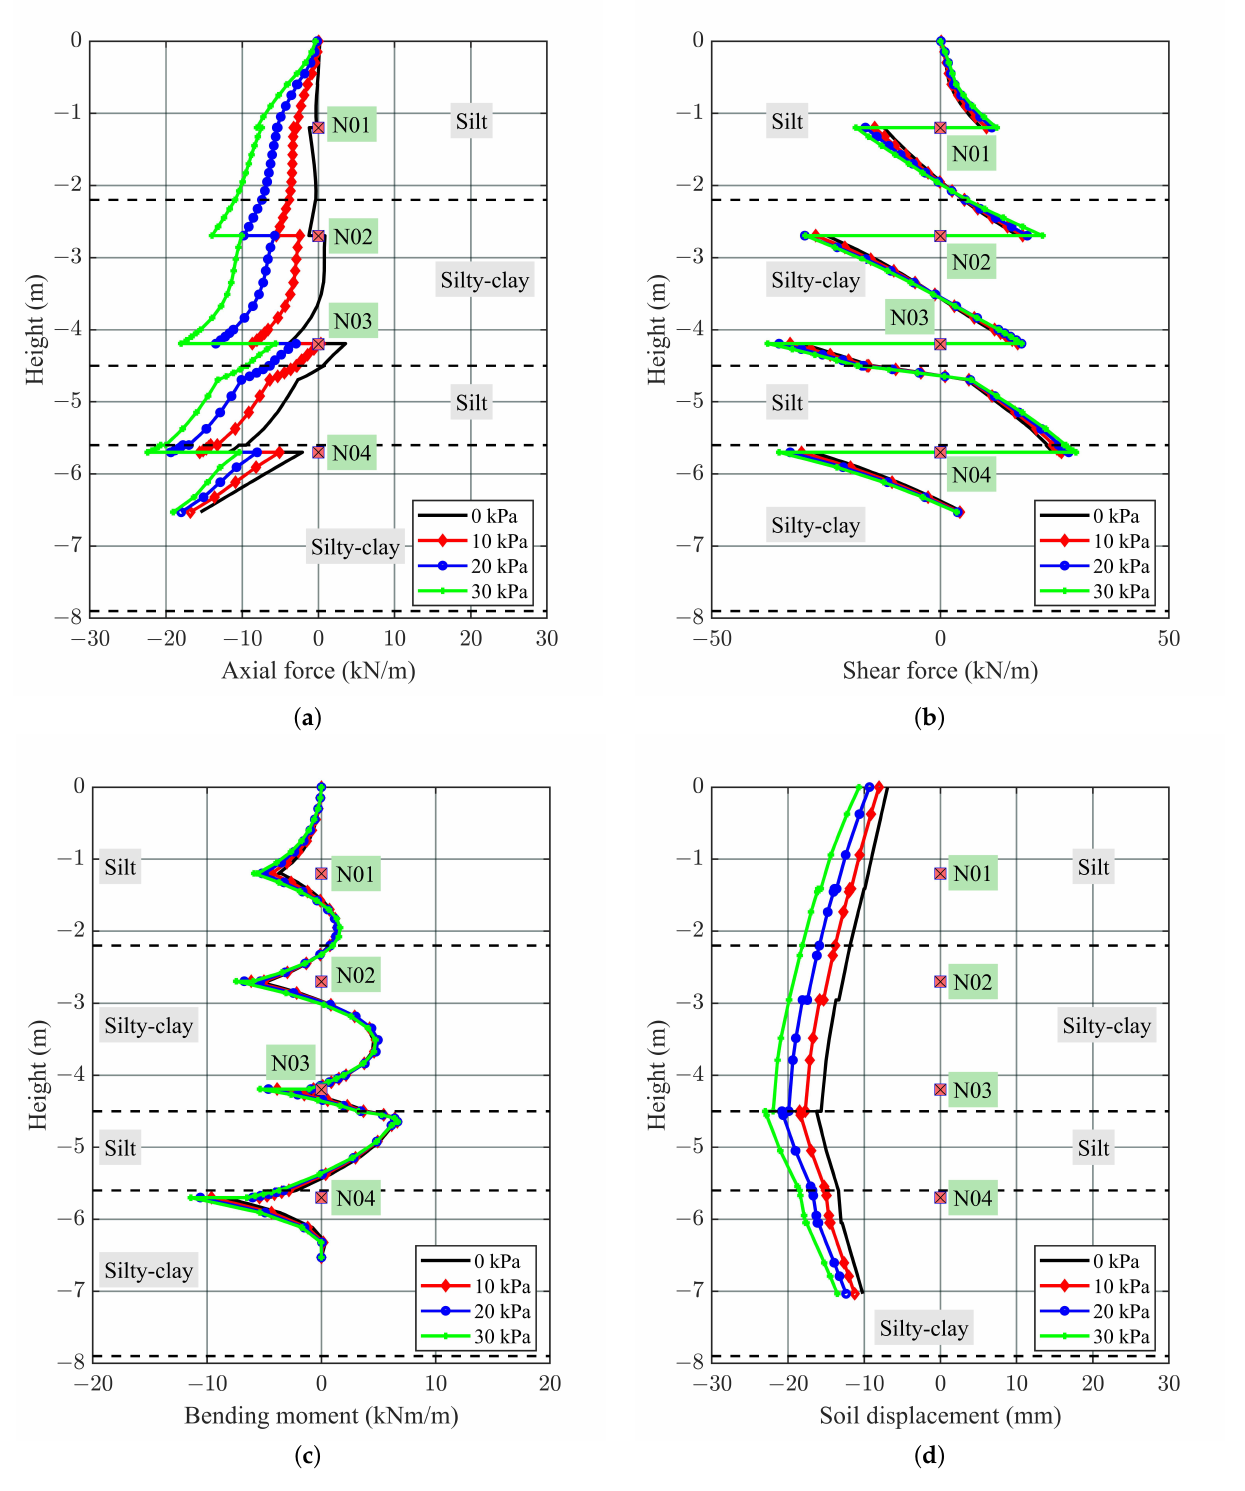
Figure 6. Surcharge loadings and responses of facing in terms of: ( a ) axial force; ( b ) shear force; ( c ) bending moment; ( d ) retained soil